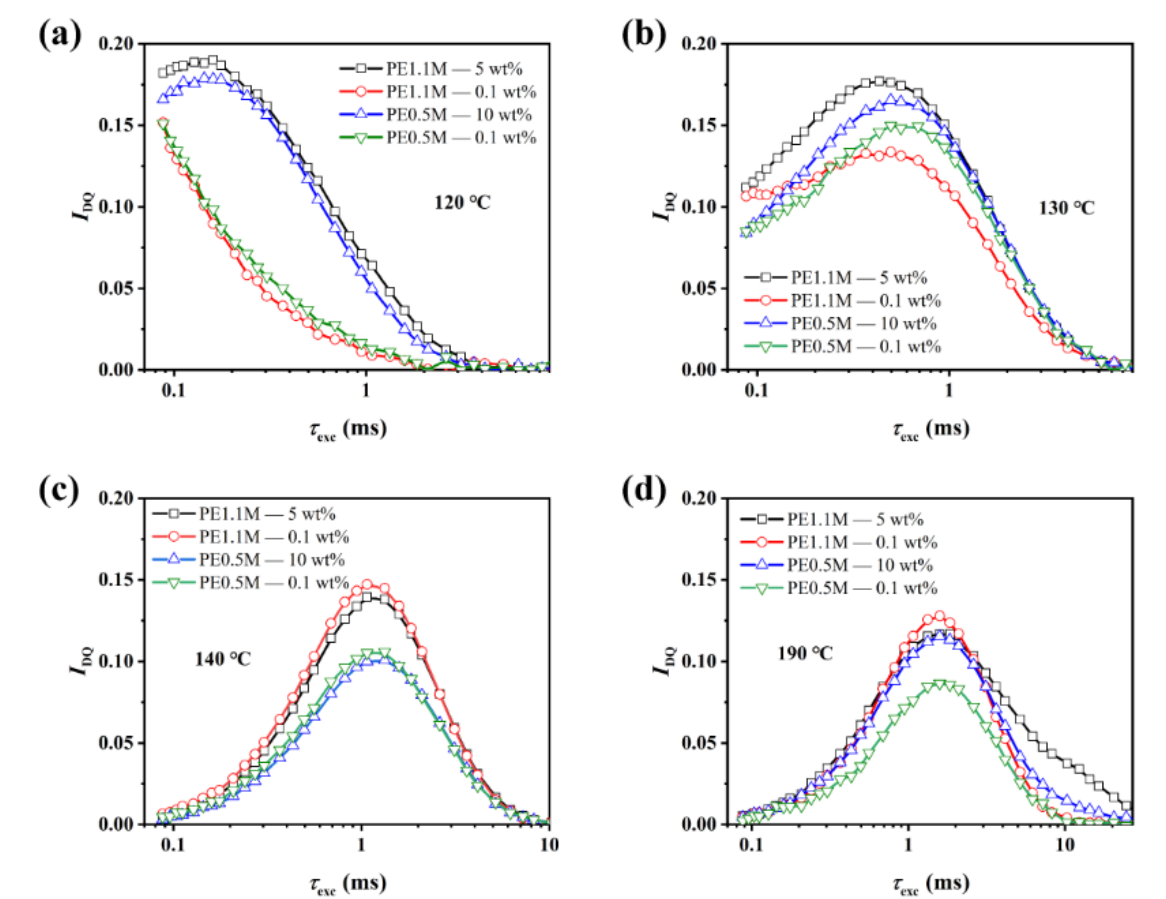
Figure 5. Original DQ buildup curves of all the PE samples at ( a ): 120 °C, ( b ): 130 °C, ( c ): 140 °C and ( d ): 190 °C.